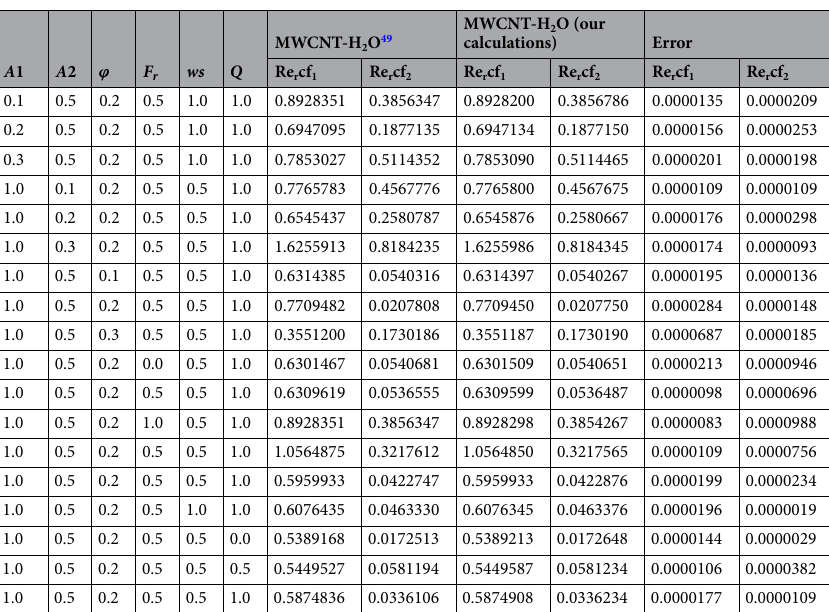
Table 10. Outcomes of skin friction coefficient for MWCNT-H 2 O at lower and upper